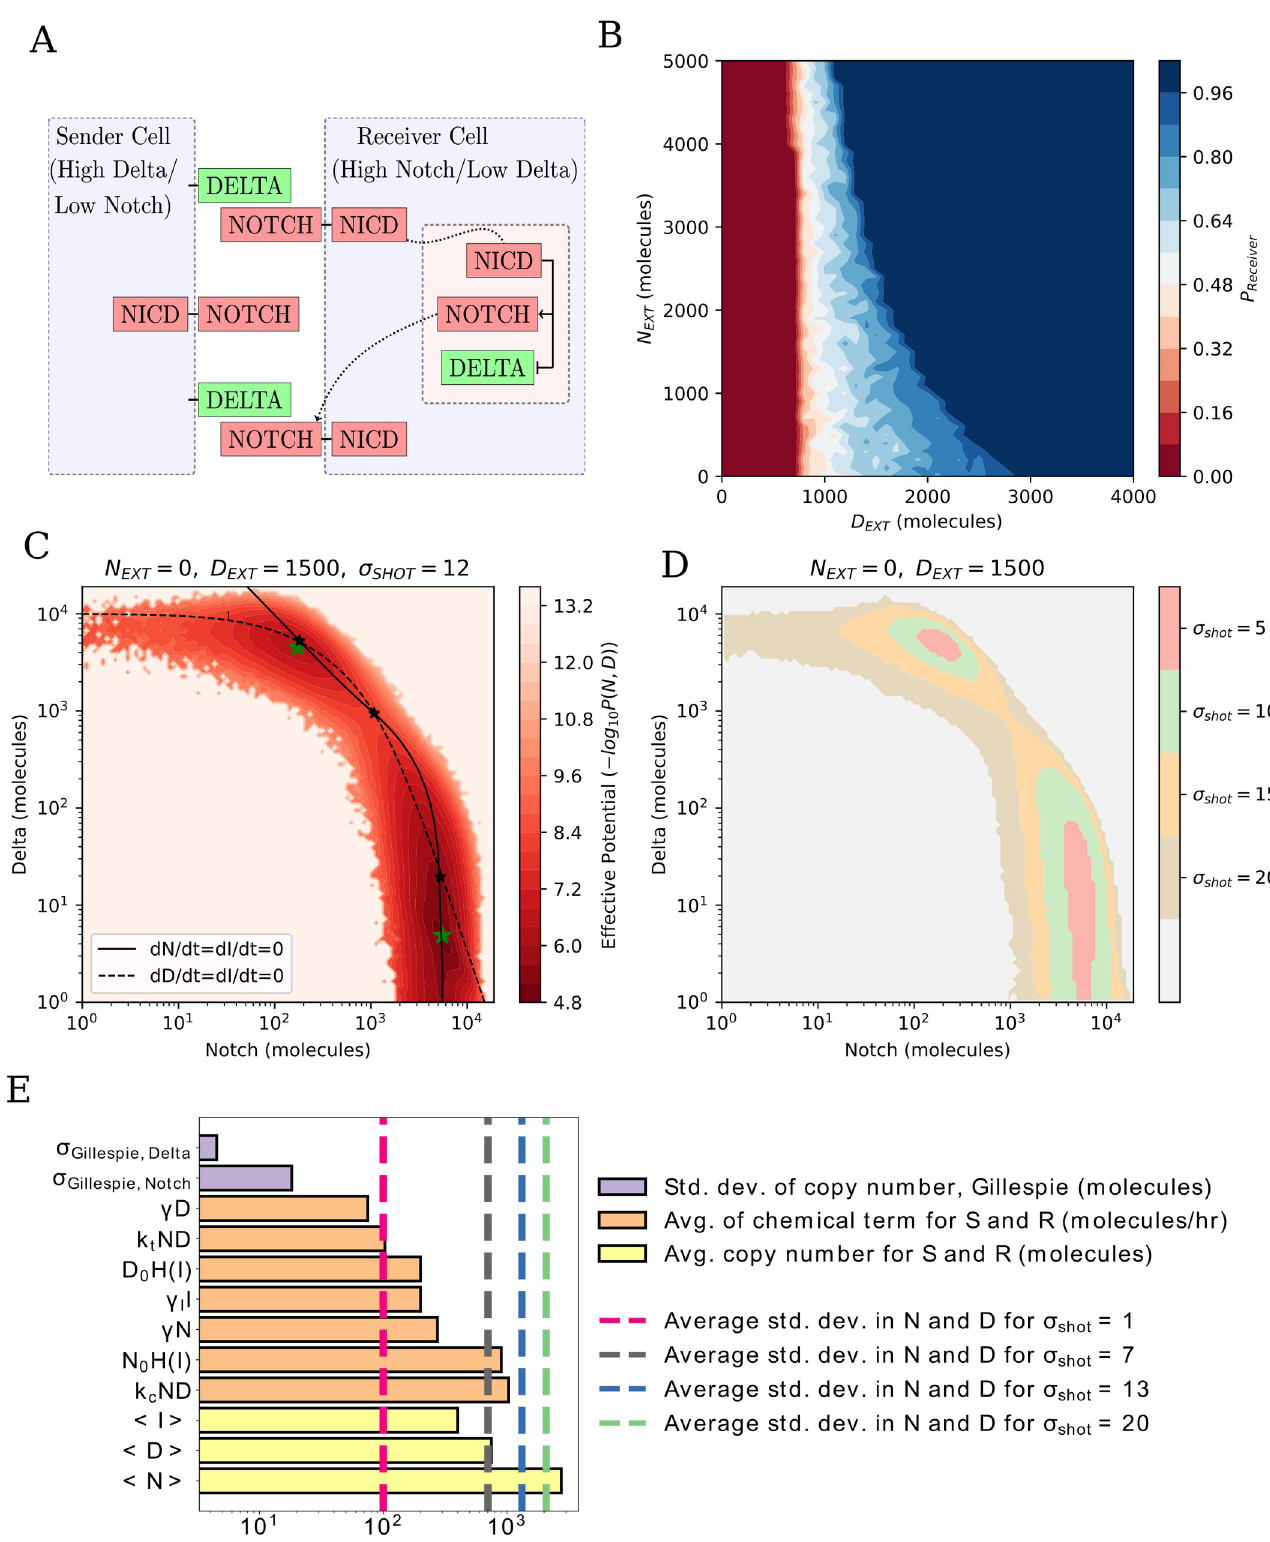
Fig 1. Effect of noise in the Notch-Delta single cell model. (a) Schematic of the Notch-Delta circuit. The Delta ligand of the Sender cell binds to the Notch transmembrane receptor of the Receiver cell. Upon binding, the Notch Intracellular Domain (NICD) translocates to the cell nucleus (pink shading), where it